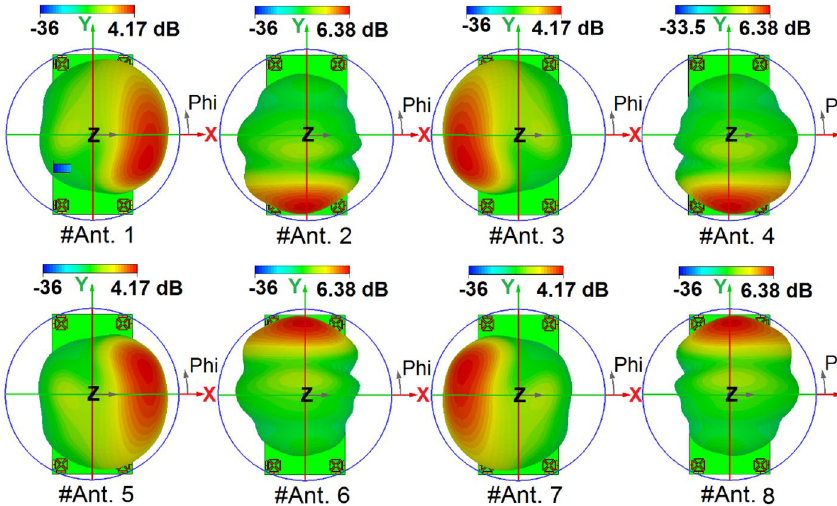
Figure 10. 3D radiation patterns with realized-gain levels for Ant.1 ~ Ant.8.